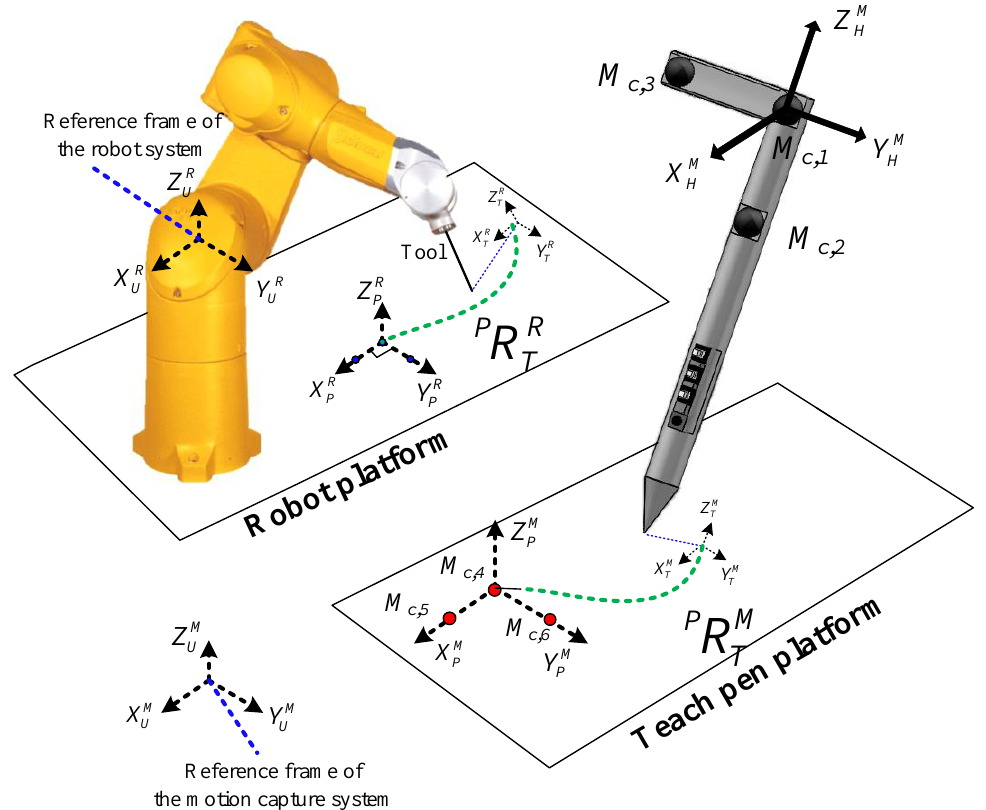
Figure 3. Relationship between the coordinate system of the teach pen and that of the robotic